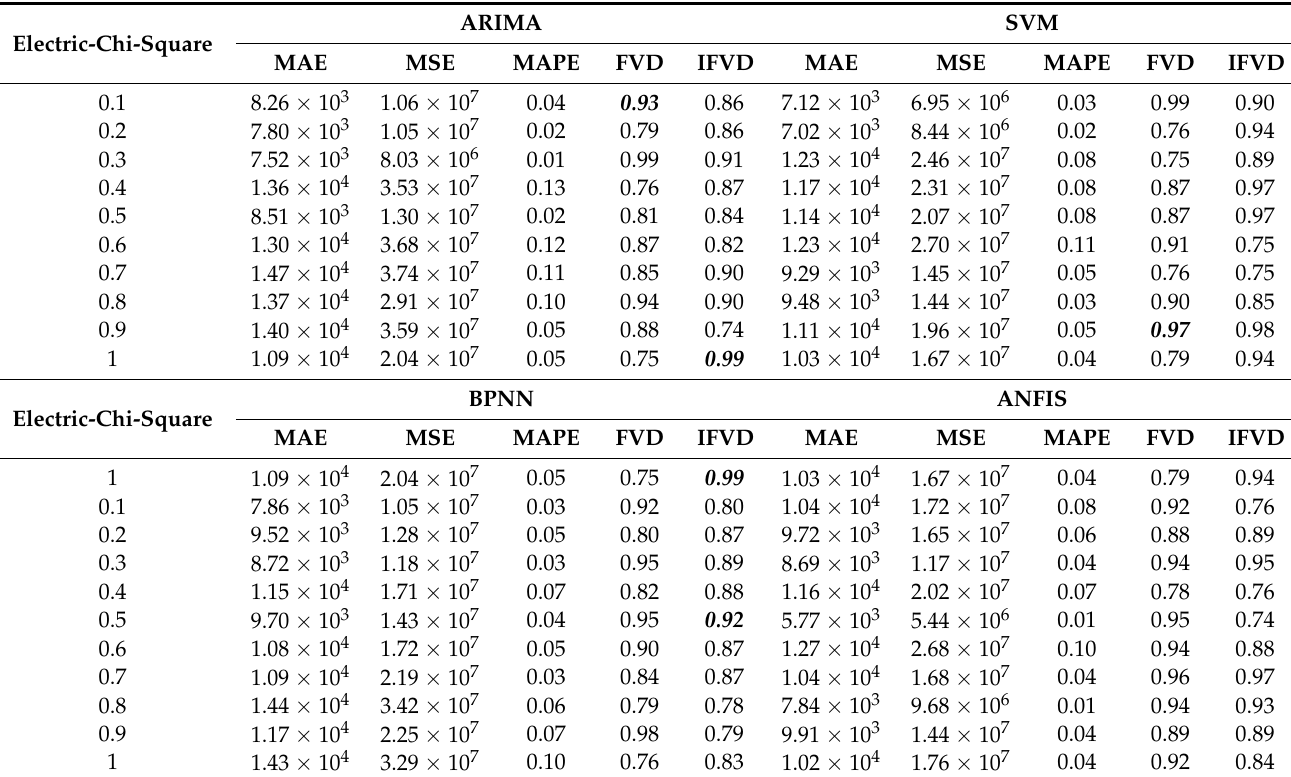
Table 8. Results of different models for EL forecasting at 5-h